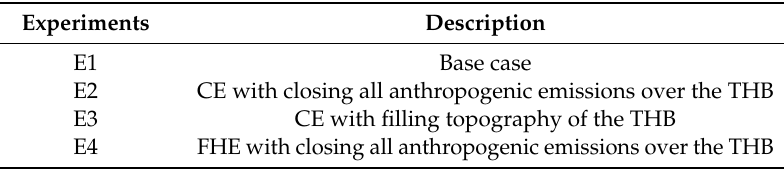
Table 2. Experimental designs in this